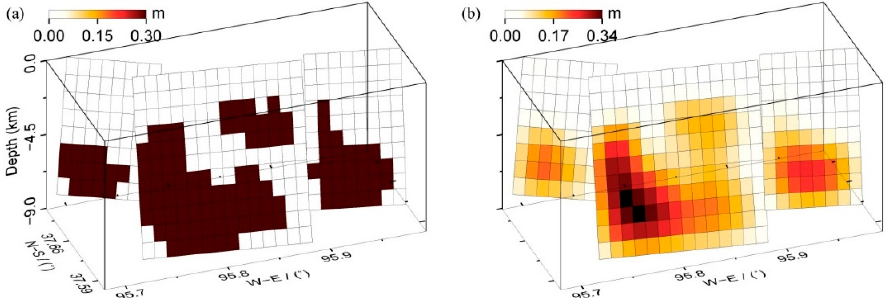
Figure 8. Resolution test. ( a ) Input slip model; and ( b ) recovered slip model. The input model in ( a ) has a slip pattern similar to the main slip (larger than 40% of its maximum afterslip) zone in Figure 6h.